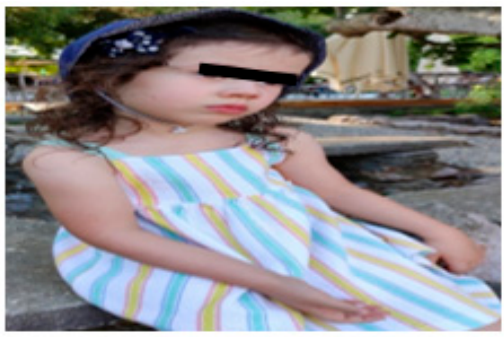
Figure 15. Injured limb at rest.